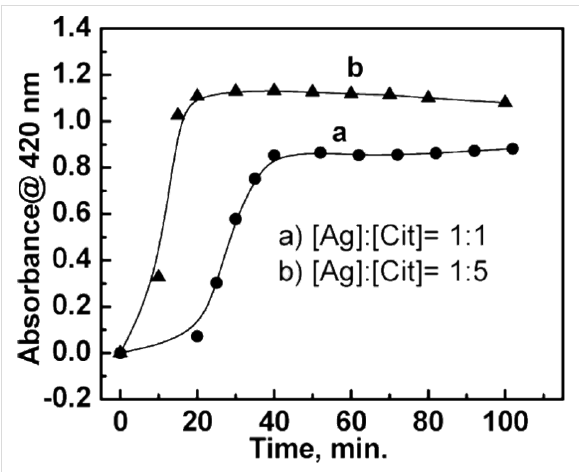
increasing the relative concentration of sodium citrate with respect to the silver cation (i.e., [Ag + ]/[citrate] = 1:5), the time required for the formation of AgNPs was reduced from 40 to 20 min when compared to a 1:1 ratio of [Ag + ]/[citrate]. Howev- er, a fraction of Ag + was not reduced according to Figure 9 [137].